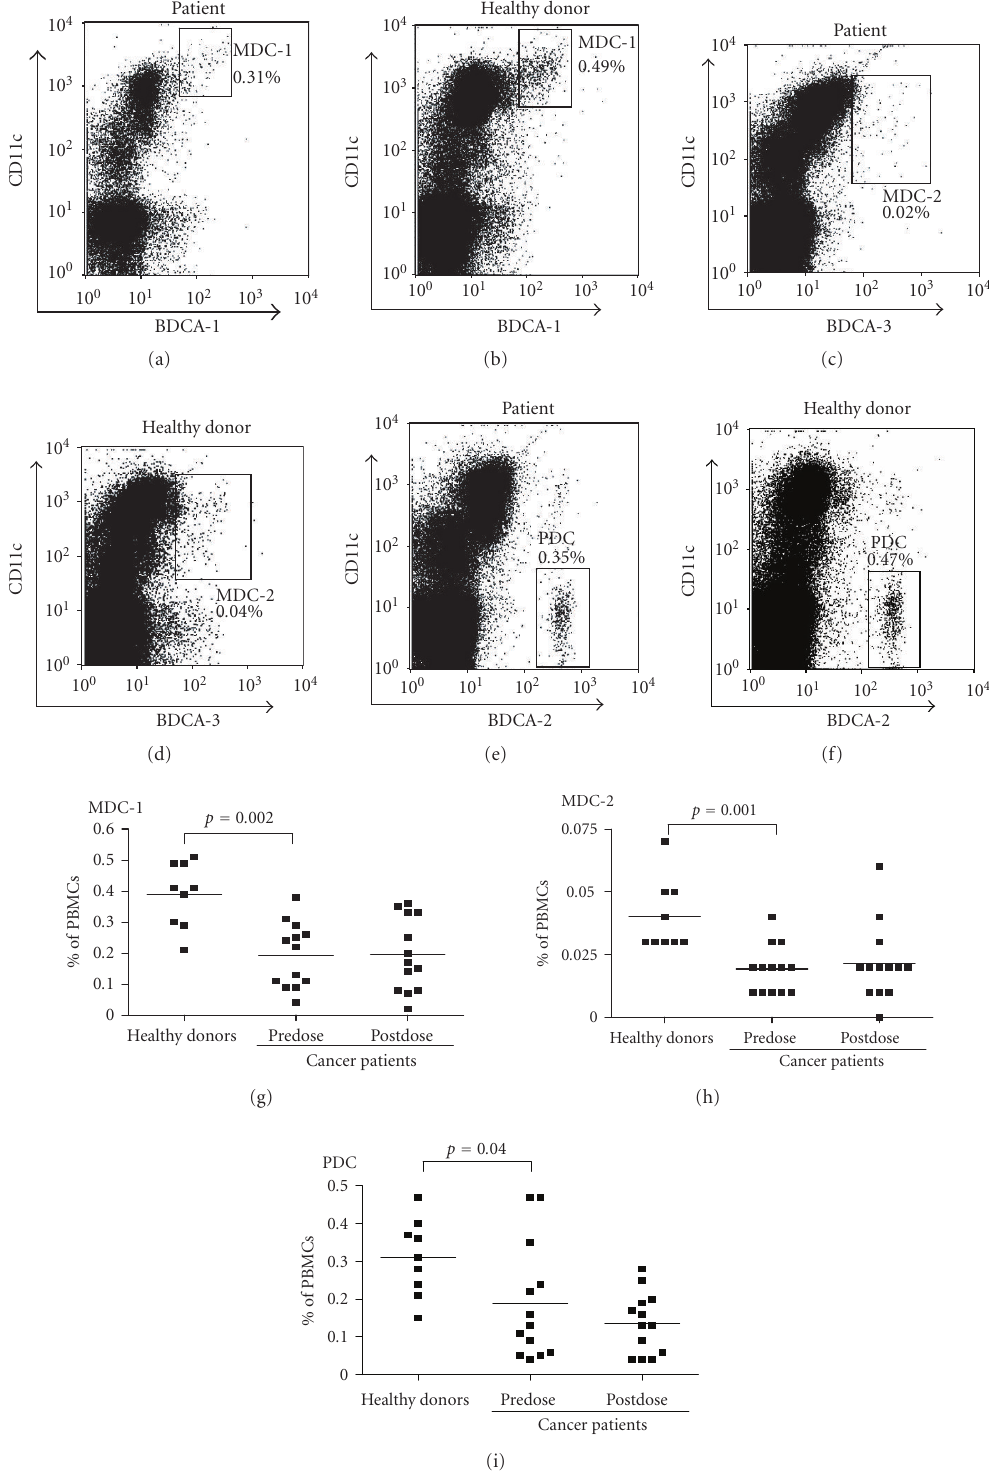
Figure 4: Typical results of peripheral blood DC monitoring based on BDCA marker analysis of a patient with fibrosarcoma (a, c, e) and one healthy donor (b, d, f). Plots for MDC-1 (BDCA-1/CD1c + (a, b)), MDC-2 (BDCA-3/CD141 + (c, d)), and PDC (BDCA-2/CD303 + (e, f)) are shown. In all plots, peripheral blood DC percentages are of total peripheral blood mononuclear cells and based on the absence of CD14 expression. MDC-1 frequencies in healthy donors and in cancer patients before (predose) and after VEGFR inhibition (postdose) (g), MDC-2 frequencies in healthy donors and in cancer patients before (predose) and after VEGFR inhibition (postdose) (h), and PDC frequencies in healthy donors and in cancer patients before (predose) and after VEGFR inhibition (postdose) (i) are shown. Peripheral blood DC percentages are of total peripheral blood mononuclear cells. In all graphs, individual values and the means are